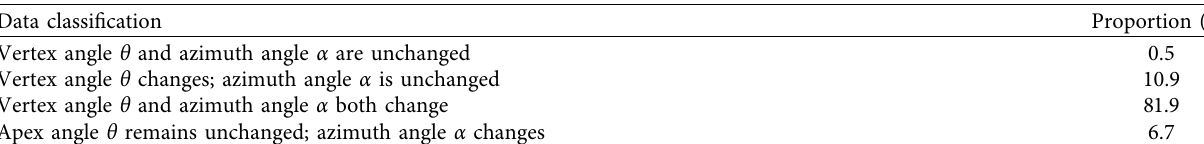
Table 7: Drilling deviation.